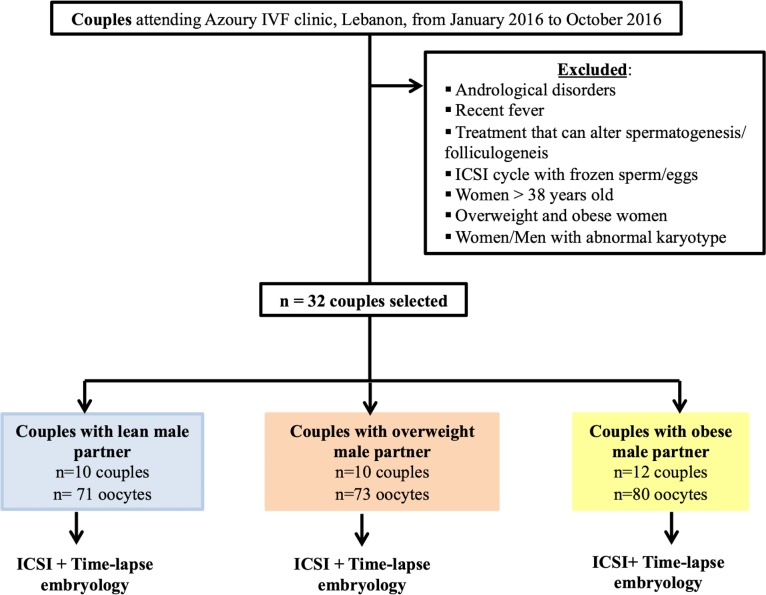
Study design for the analysis of the embryo morphokinetics from the three different groups.For this part of this study, all the semen samples were processed using the swim-up procedure.